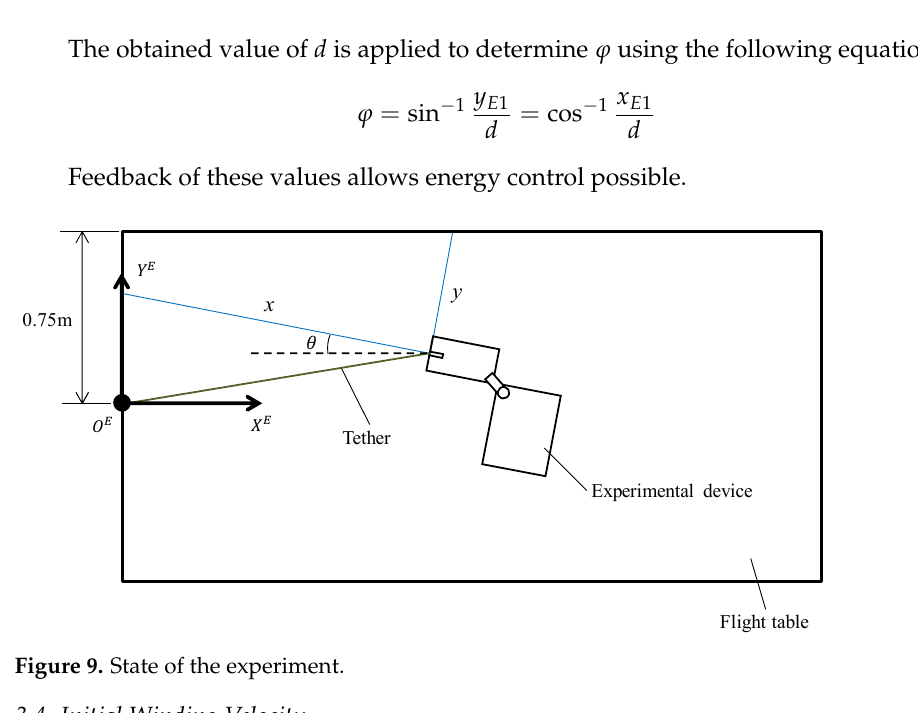
8 experiment. The coordinate system was based on the center of the flight table short side, 𝑂 (cid:3006) − 𝑋 (cid:3006) 𝑌 (cid:3006) ; the 𝑥 -coordinate of the suction port tip, 𝑥 (cid:3006)(cid:2869) ; and the 𝑦 -coordinate of the suc-